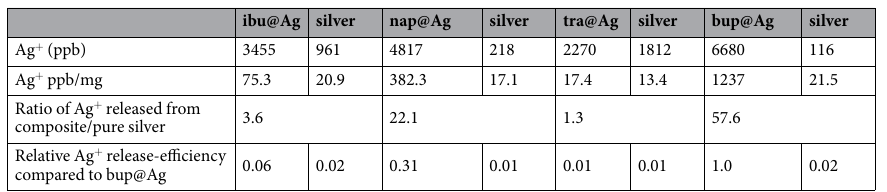
Table 6. Comparative Ag +